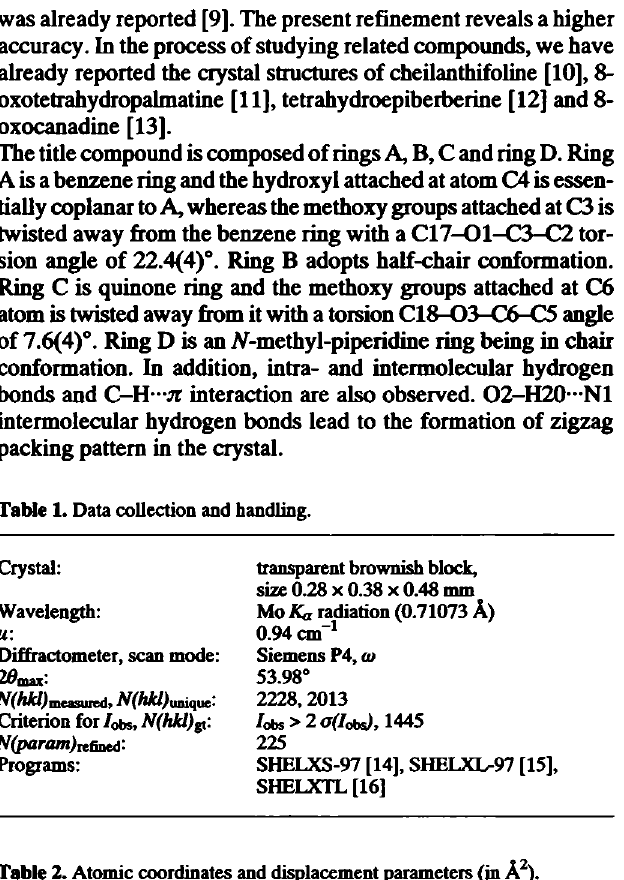
Table 2. Atomic coordinates and displacement parameters (in Ä 2